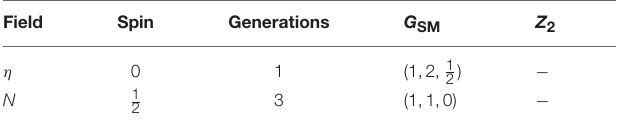
TABLE 9 | Quantum numbers of new particles in the scotogenic model.